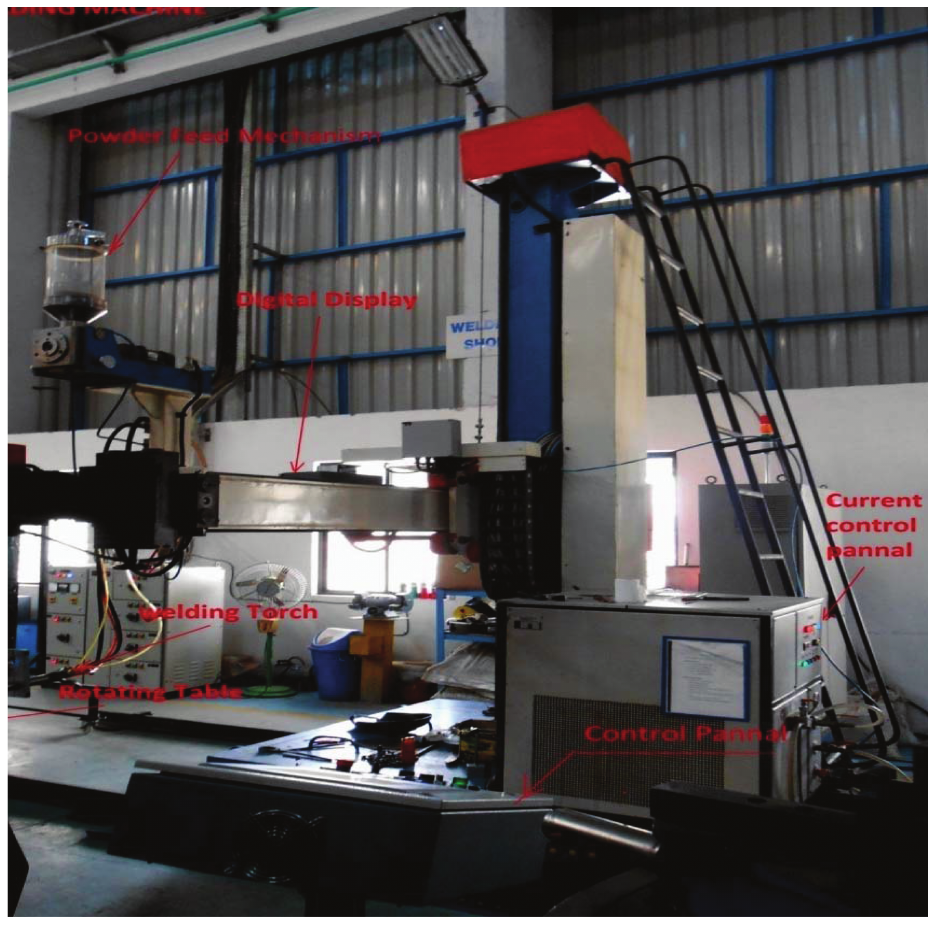
Figure 1: PTAW machine used for